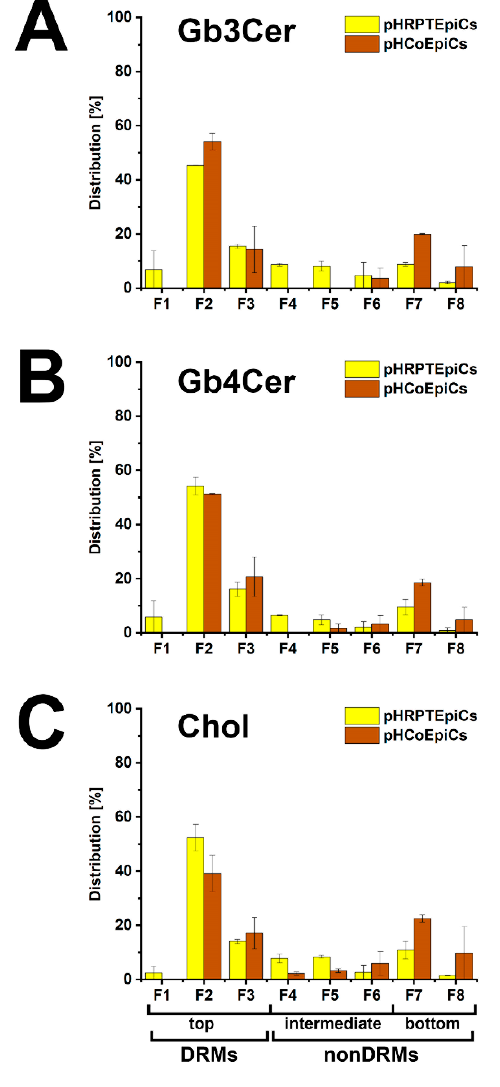
Figure 6. Bar chart illustration of the distribution of Gb3Cer ( A ), Gb4Cer ( B ), and cholesterol ( C ) to sucrose gradient fractions F1 to F8 obtained from pHRPTEpiCs and pHCoEpiCs. The immunostained TLC bands of Gb3Cer and Gb4Cer and the cholesterol spots shown in Figure 5 were densitometrically quantified and normalized for each fractionation to 100%. For further details refer to Detzner and collaborators [193,194], where the data were taken from.